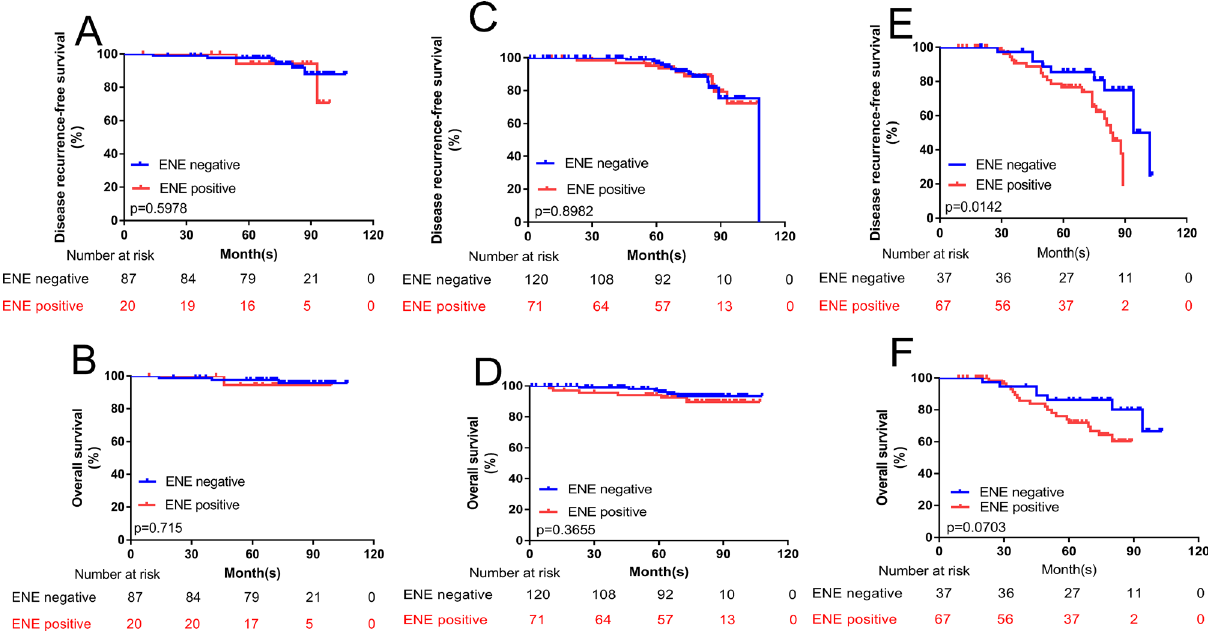
Figure 4. Kaplan–Meier curves and Log-rank test show associations of ENE in ALN with DRFS and OS in whole patients with different nodal (N) stage. ( A , B ) Comparison of survival rate for DRFS (ENE negative group vs. ENE positive group: p = 0.557) ( A ) and OS (ENE negative group vs. ENE positive group: p = 0.547) ( B ) between different ENE groups in patients with N1 stage. ( C , D ) Comparison of survival rate for DRFS (ENE negative group vs. ENE positive group: p = 0.919) ( C ) and OS (ENE negative group vs. ENE positive group: p = 0.367) ( D ) between different ENE groups in patients with N2 stage. ( E – F ) Comparison of survival rate for DRFS (ENE negative group vs. ENE positive group: p = 0.047) ( E ) and OS (ENE negative group vs. ENE positive group: p = 0.346) ( F ) between different ENE groups in patients with N3